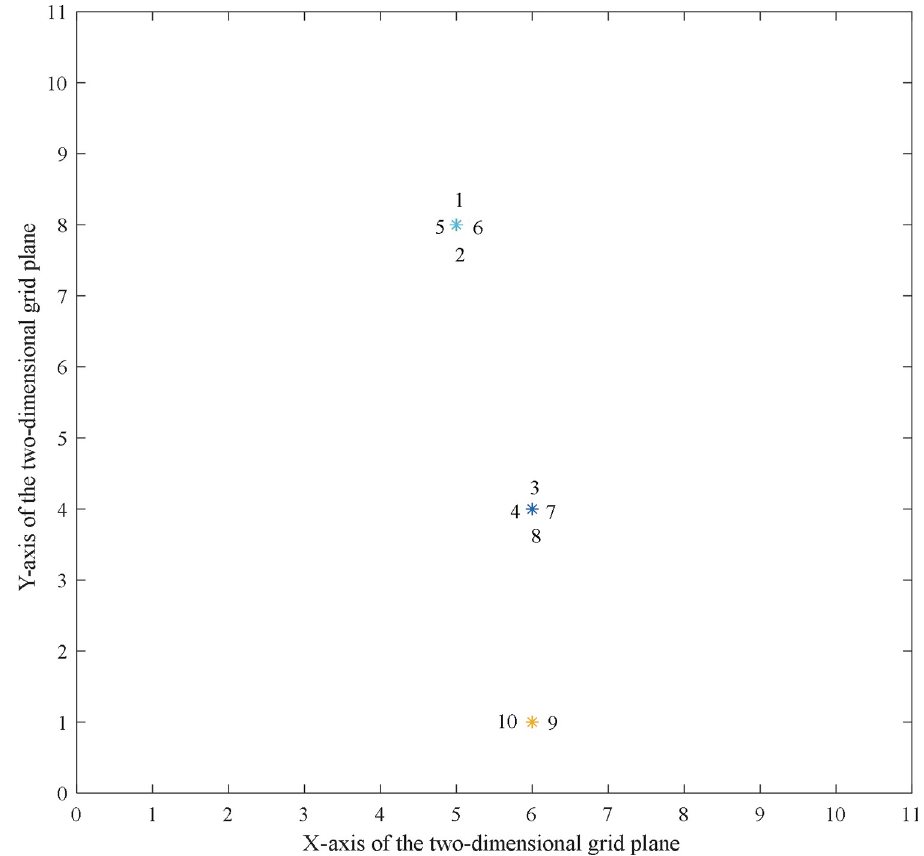
Fig 5. The clustering partition results.